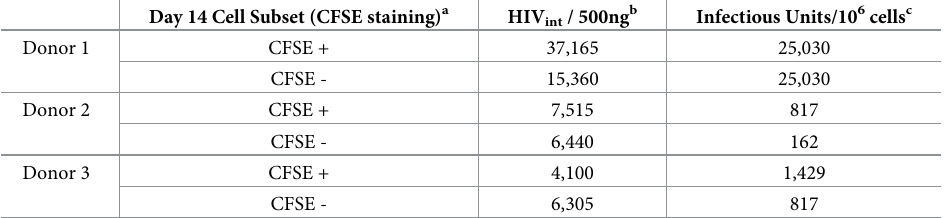
Table 3. Integrated HIV copies and cell-associated infectious units in non-dividing (CFSE + ) vs dividing (CFSE - ) subsets. Day 14 Cell Subset (CFSE staining) a